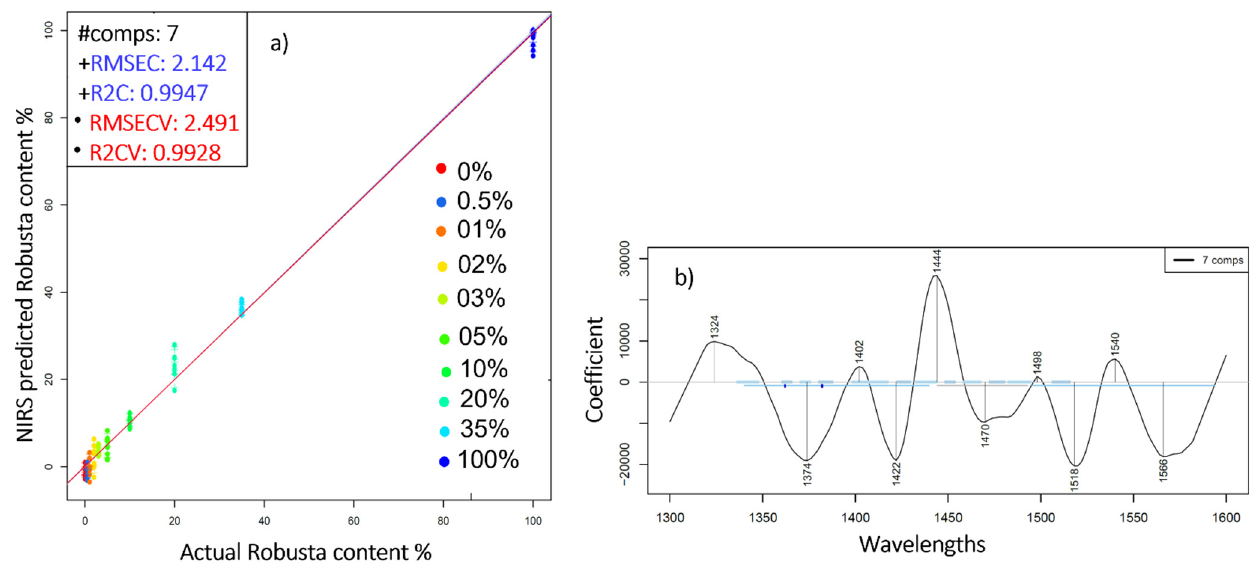
Figure 3. ( a ) PLSR analysis of the ground coffee mixtures derived from the smoothed (Savitzky-Golay smoothing (window size 19)) first derivative spectra for the prediction of added Robusta (% w / w ); ( b ) The respective regression vector in the range 1300–1600 nm.